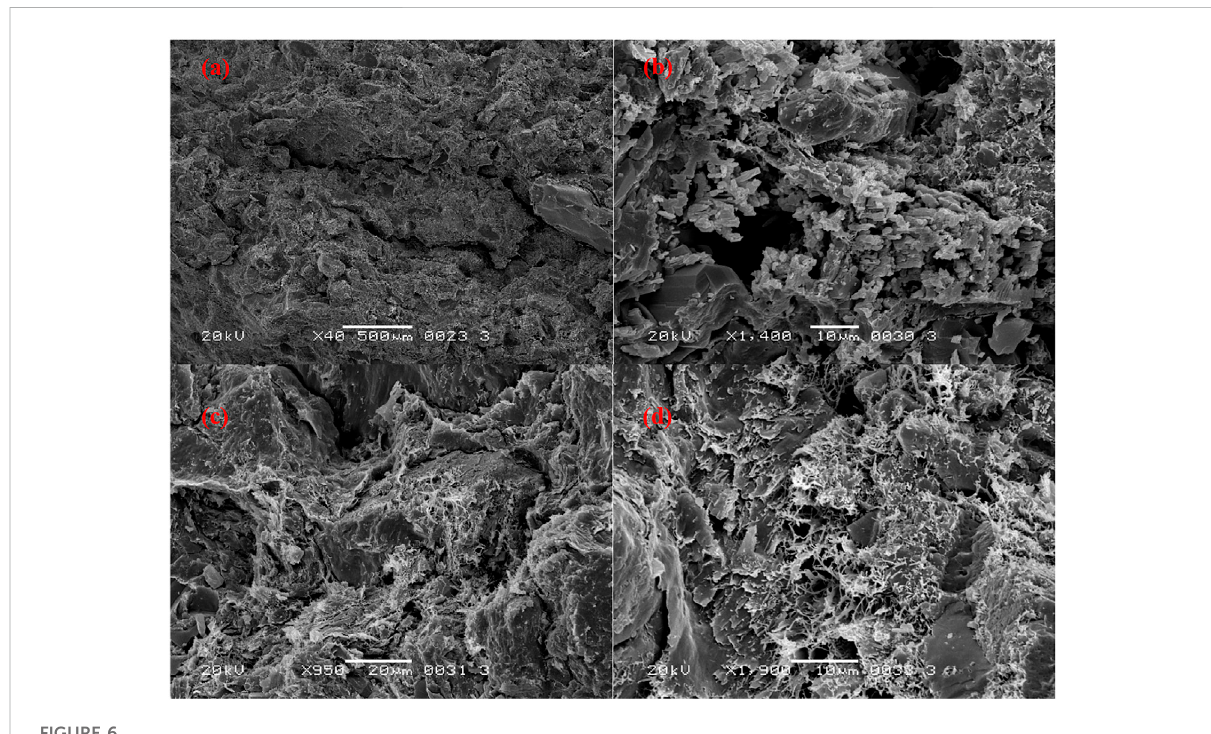
FIGURE 6 SEM image of core 5 of Zhoufu 59 – 51